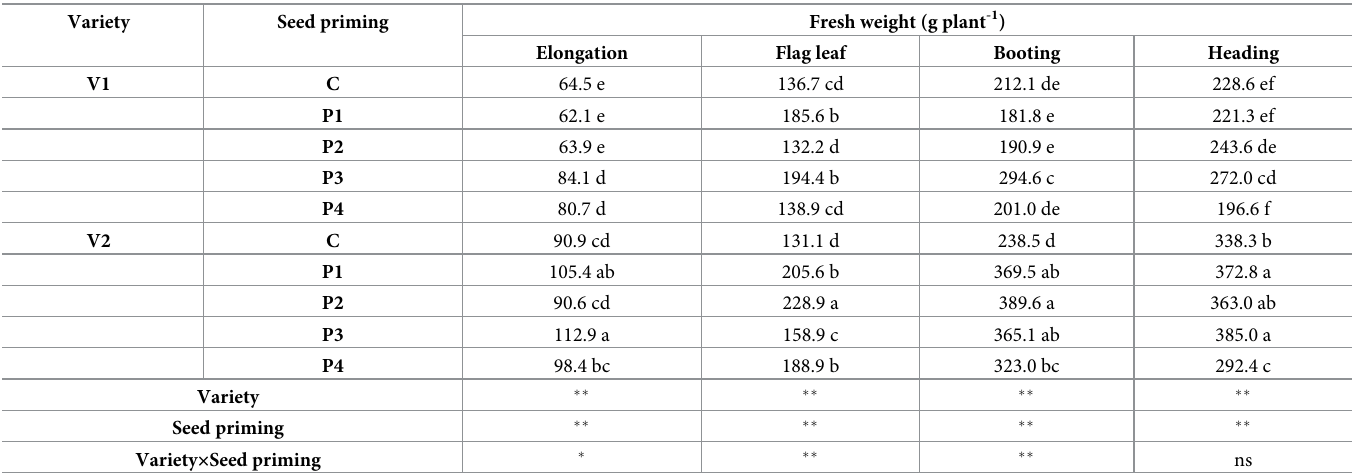
Table 1. Effect of seed priming on fresh weight of sorghum under salt stress at different growth stages. Variety